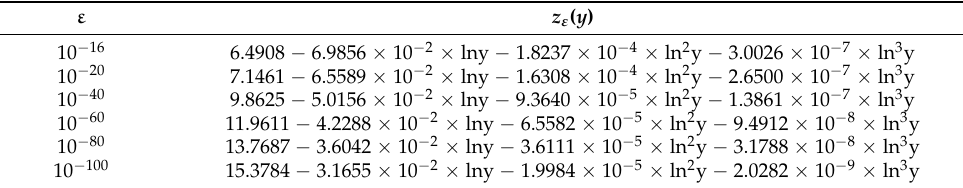
Table 1. Approximation formulas for z ε ( y ) ( y ≤ 0.1).